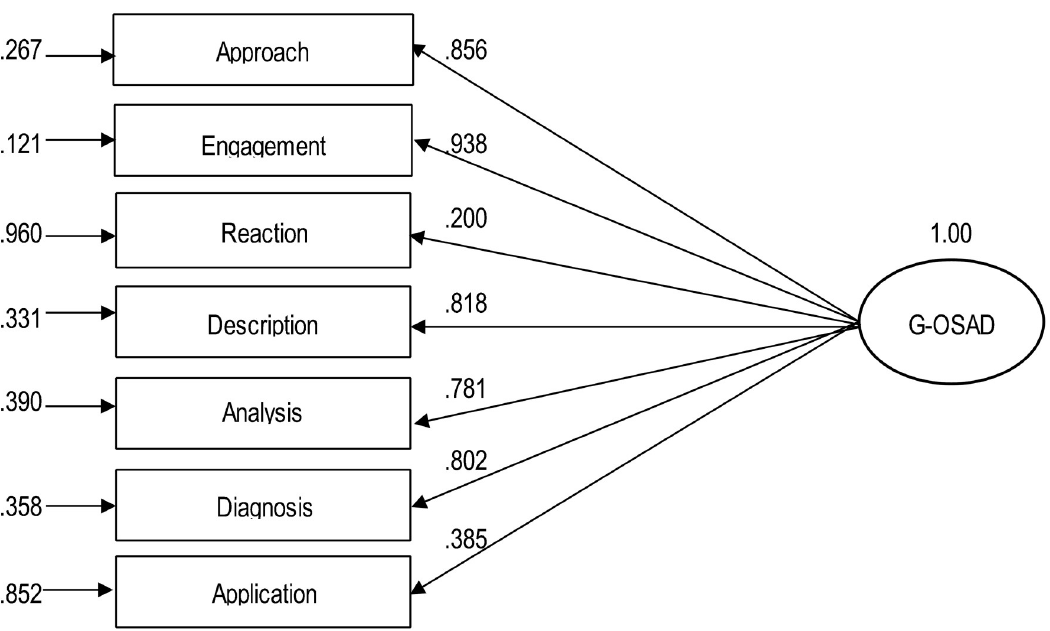
Fig 1. Factor structure of the G-OSAD. Full model and standardised parameter estimates. Rectangles, observed variables; oval, latent construct. The paths from the latent construct to the observed variables indicate the standardised loading ( β ) of each variable. The arrows to the observed variables (left) indicate the measurement errors ( ε ). The category of ‘establishes learning environment’ was not assessed because it was not part of the video recordings of the debriefings, and therefore it was excluded.